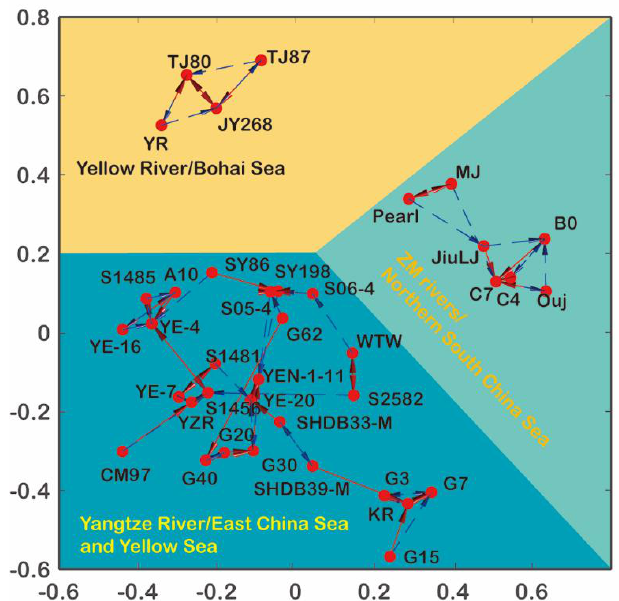
Figure 6. Multidimensional scaling (MDS) configuration of samples in the ECSs. There are three distinct groups in the MDS configuration, which could be linked to the potential sources. The solid (red) and dash (blue) lines denote the first and second closest neighbors, which indicate more similar age distributions and closer provenance linkages.